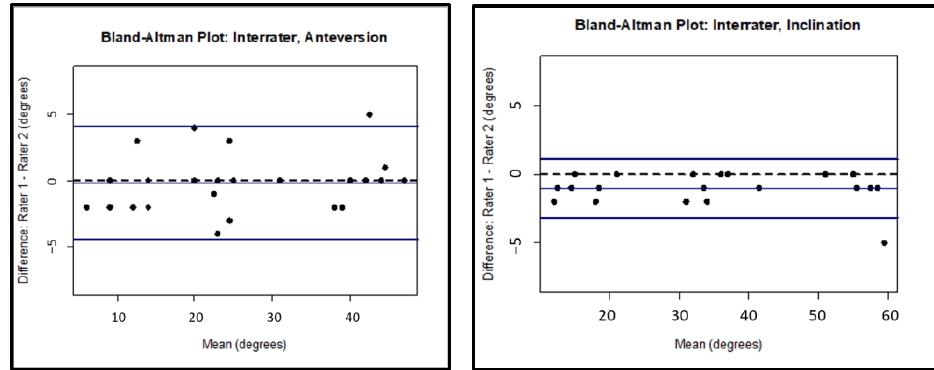
Figure 5. Bland – Altman limits of agreement for the interrater analysis for the cup only images. Comparing anteversion measurements taken with images containing only the acetabular cup with no femoral head, interpreted by the same investigator two weeks apart, an intrarater reliability ICC of 0.995 (95% CI: 0.985 – 0.998) was calculated. For inclination using the same images, an intrarater agreement ICC of 0.998 (95% CI: 0.994 – 0.999) was calculated.